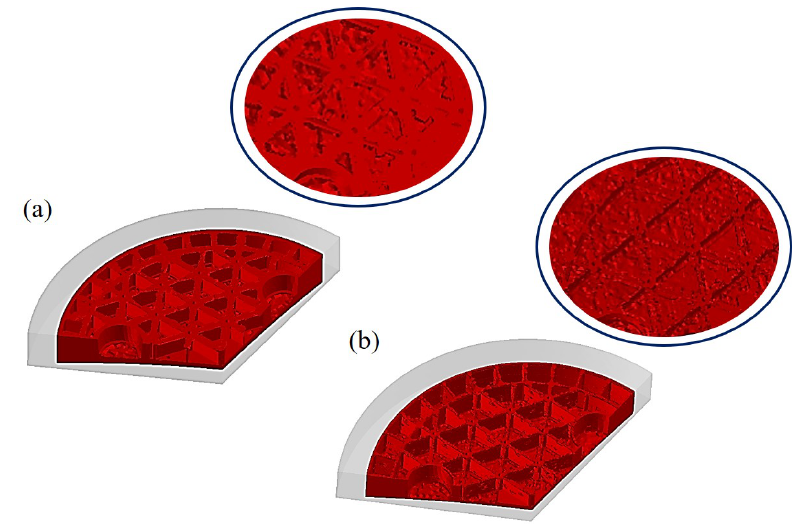
Figure 11. Temperature field for the gating system. ( a ) Without exhaust hole and ( b ) with exhaust